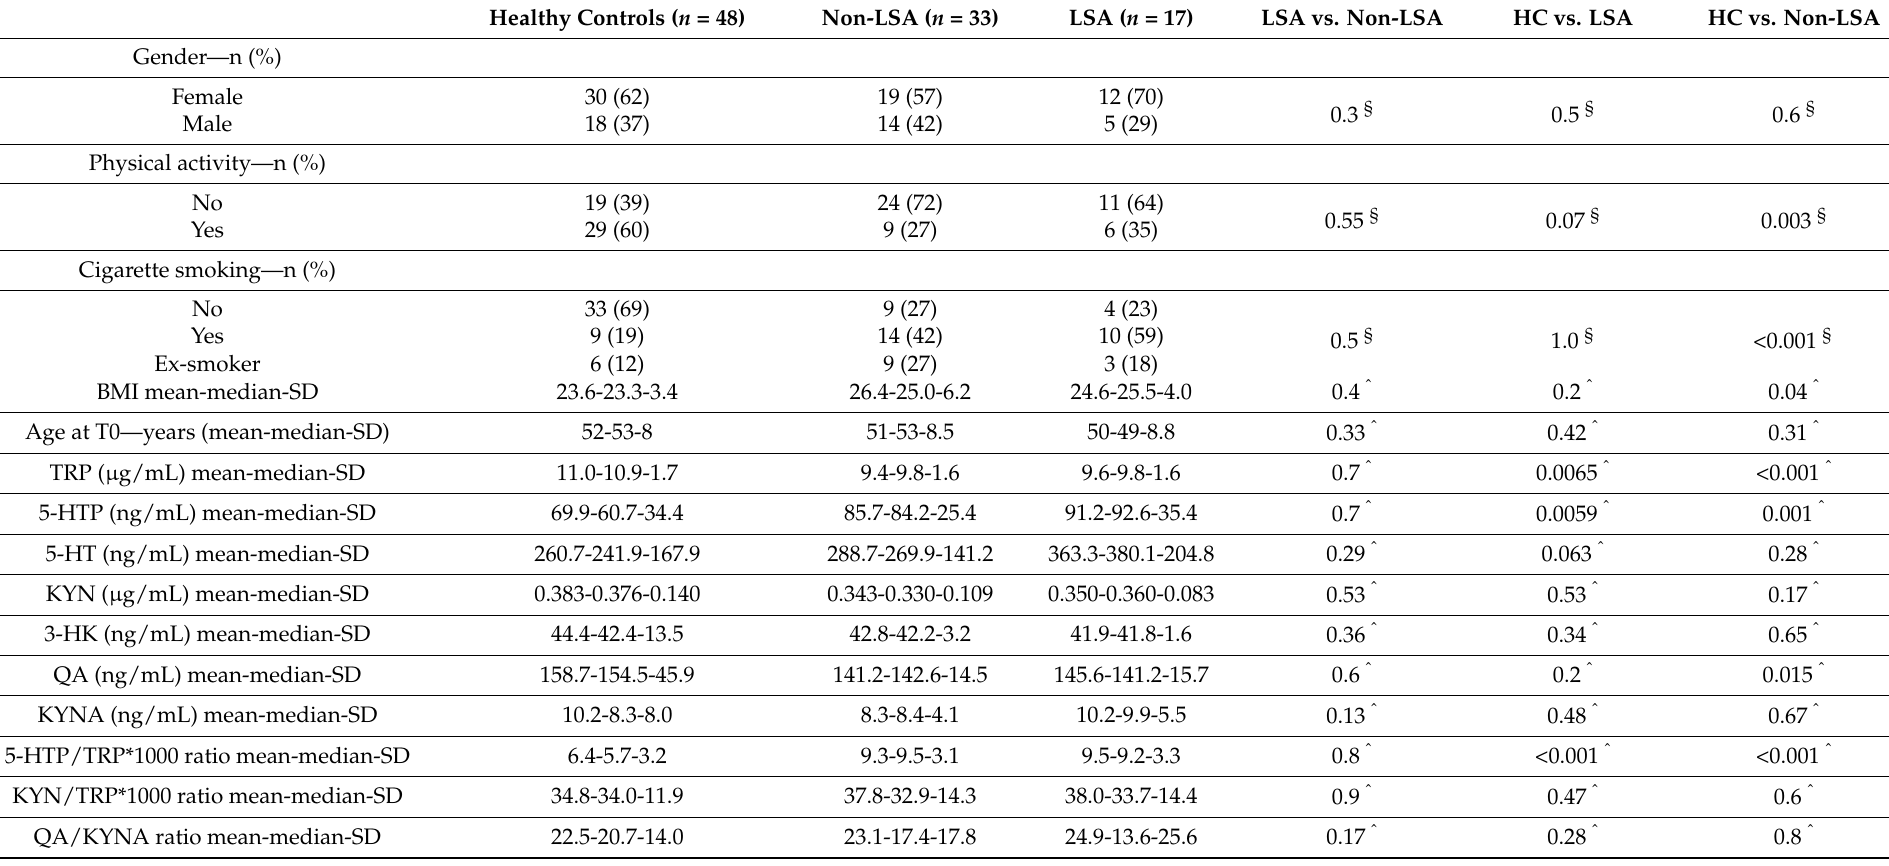
Table 1. Sociodemographic data and plasma concentration for the tested TRP